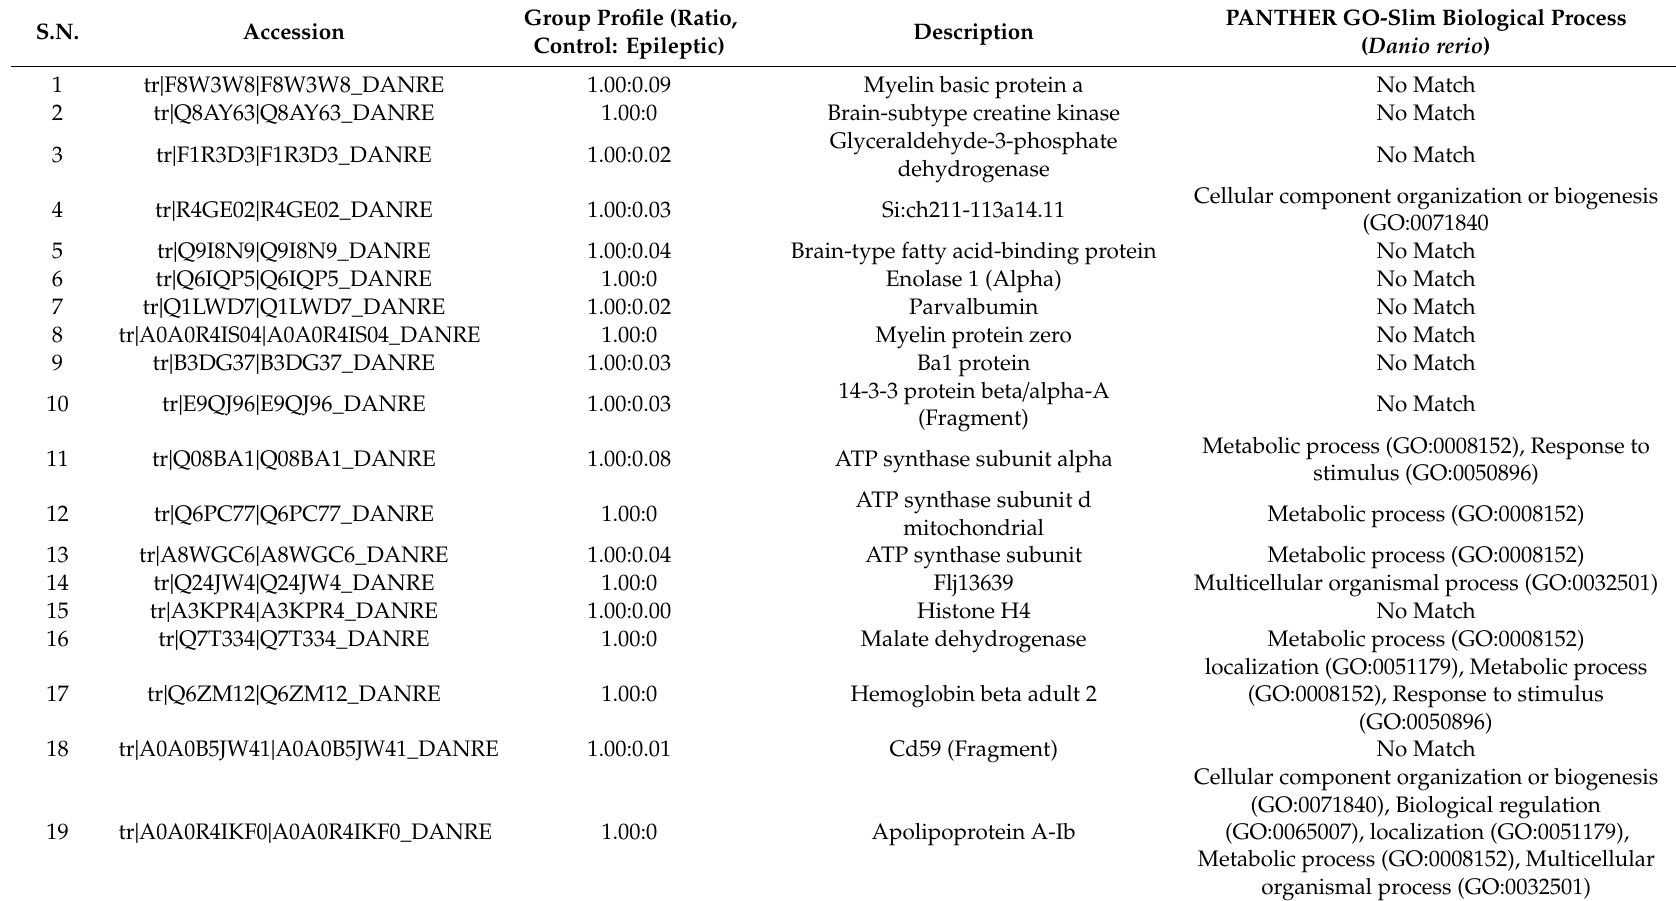
Table 4. Proteins identified from zebrafish brain extract (control vs epileptic) with di ff erential expression based on label free quantification approach. Biological process for the proteins were identified using PANTHER-GO classification system